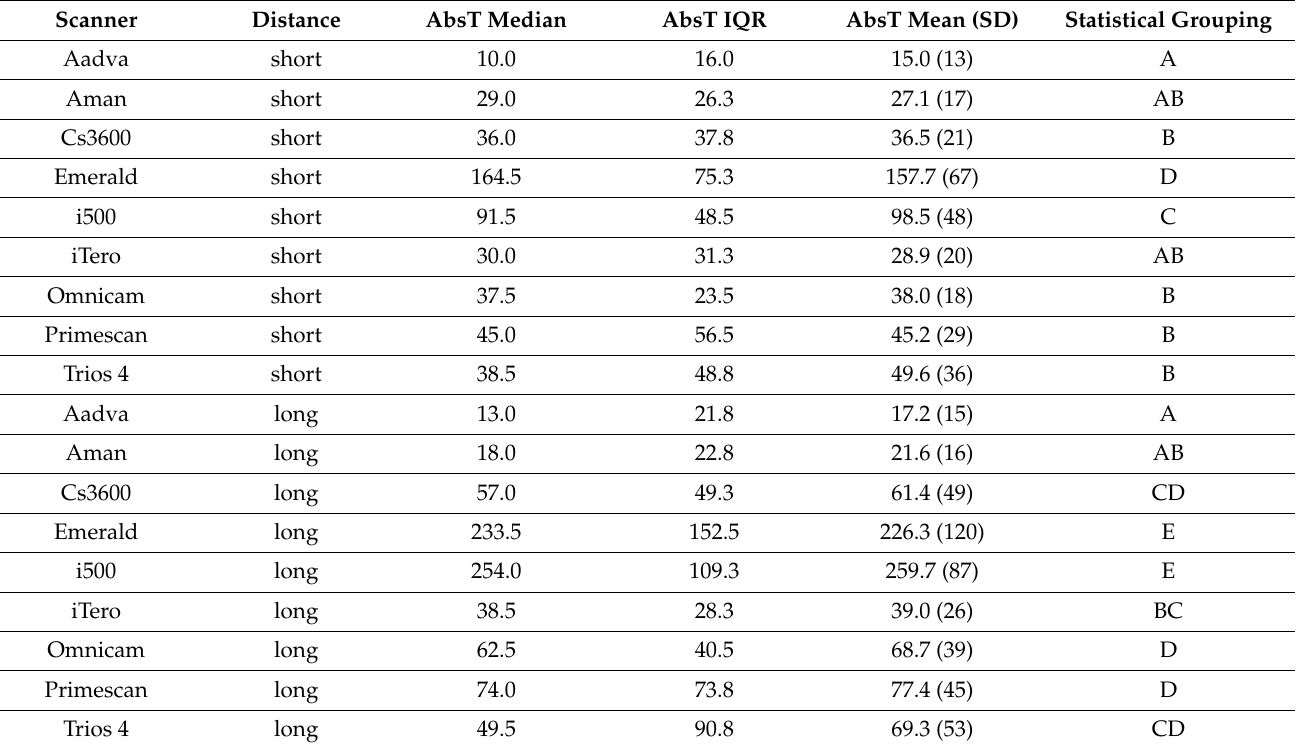
Table 4. Descriptive statistic values of absolute median, interquartile range (IQR), mean, and standard deviation (SD) for trueness ( µ m). Groups with the same letter in the same distance are not statistically different.